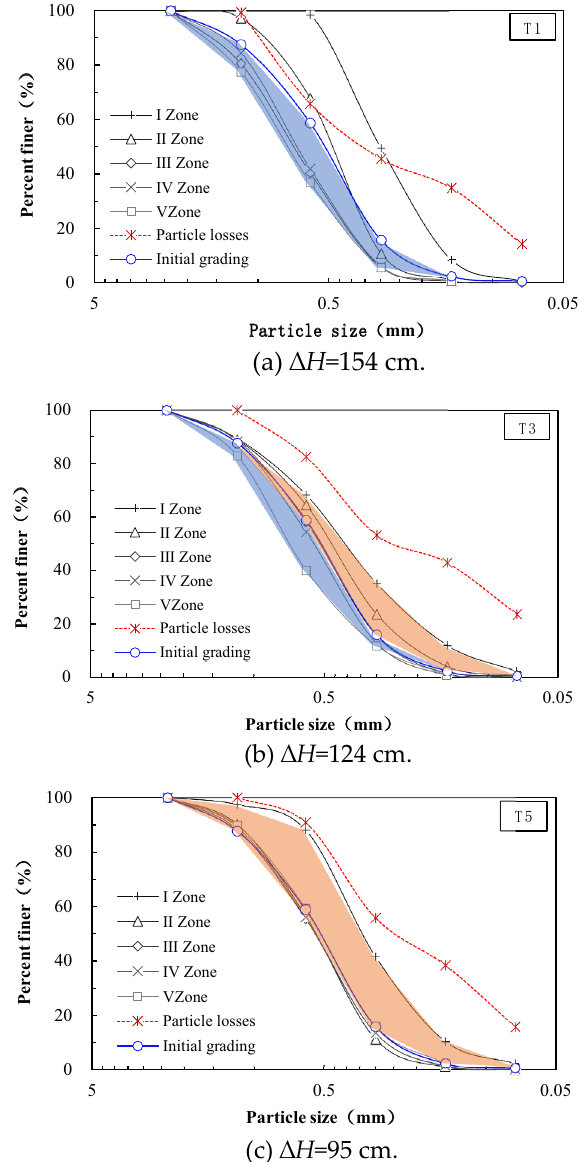
Figure 6. Grading curve of sand samples in each sand